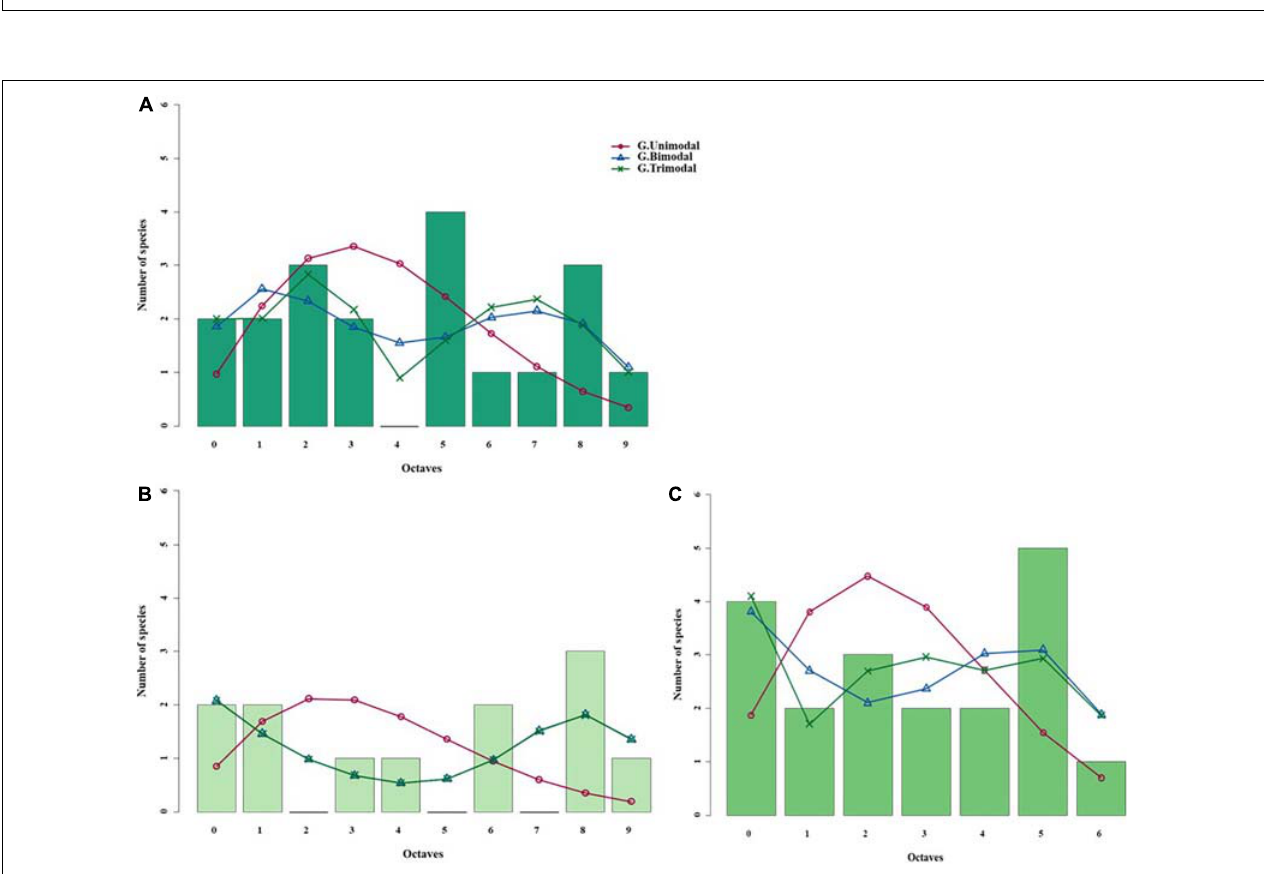
FIGURE 5 | Species abundance distributions (SADs) of carabid beetles in a Chinese meadow steppe fitted with unimodal, bimodal and trimodal gambin models. Analyses were done for the whole steppe (A) and two different sectors separately [ (B) ms1 sector, (C) ms2 sector].